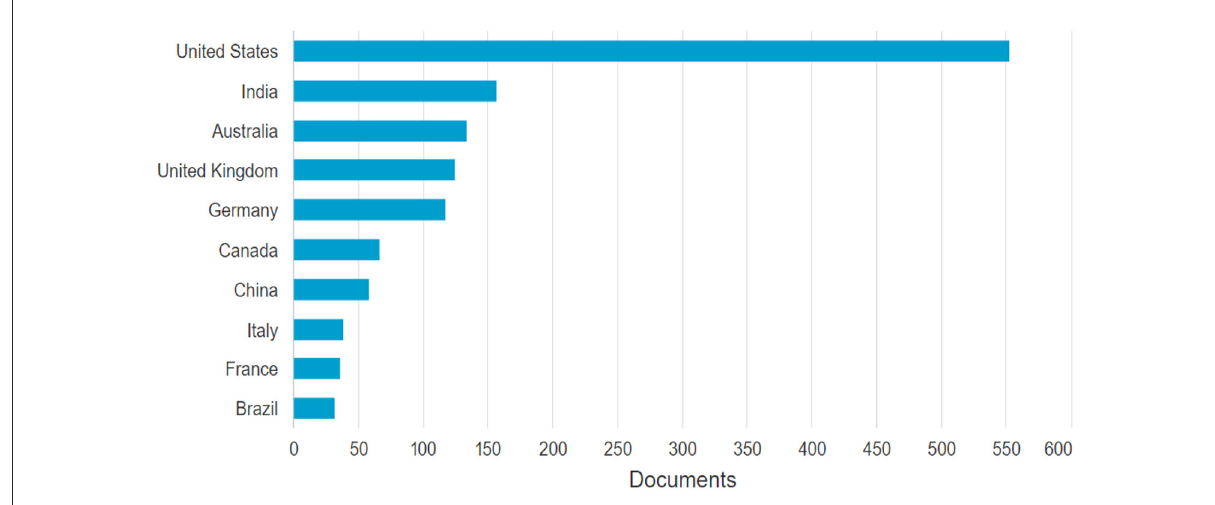
FIGURE8 Countries of publication. Source: Own elaboration using